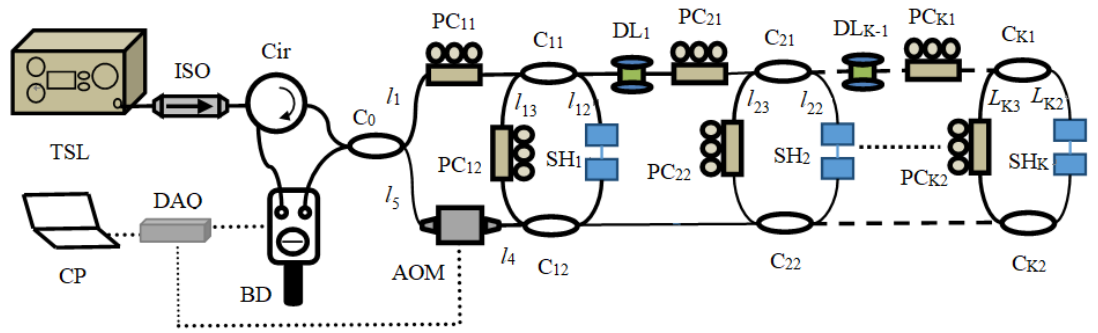
Figure 1. Schematic of the FSI-FLRD multipoint strain sensing system. TSL: tunable semiconductor laser; ISO: isolator; Cir: circulator; C 0 : 3 dB fiber coupler; C i1 , C i2 : 99.5 / 0.5 fiber couplers; PC i1 , PC i2 : polarization controller; SH i : sensor head; DL i : fiber delay line; AOM: acousto-optic modulator; BD: balanced detector; DAQ: data acquisition card; CP: